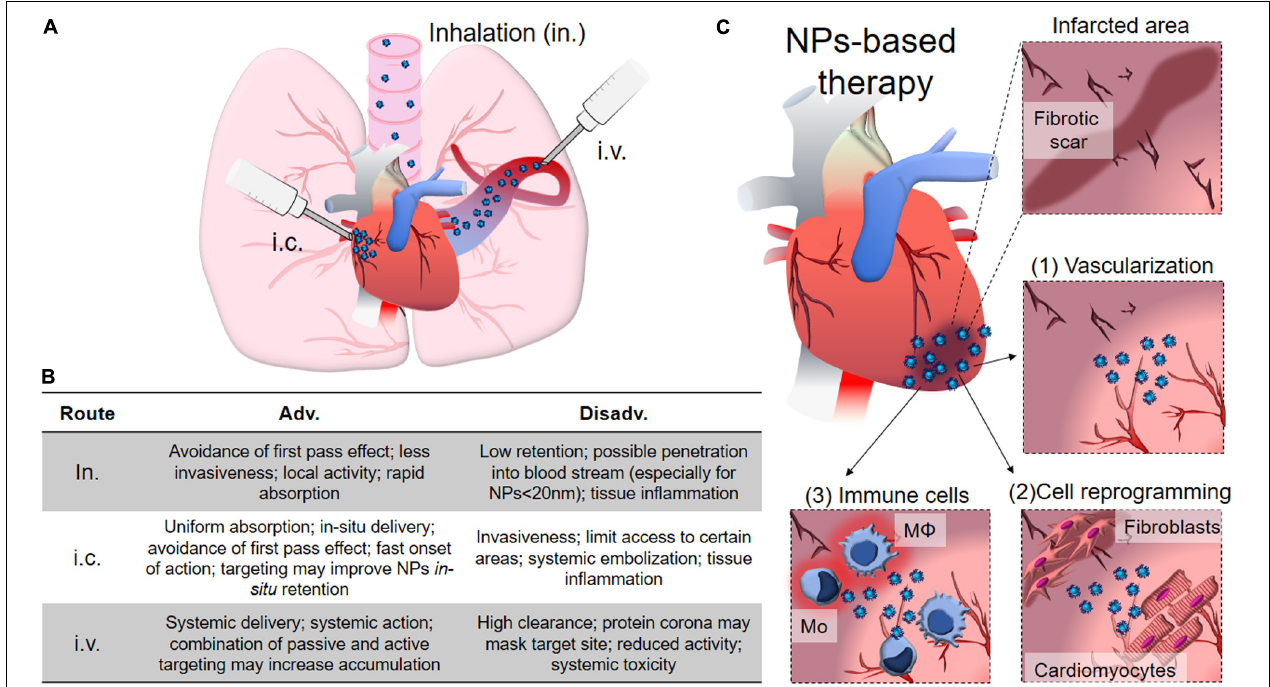
FIGURE 4 | NPs for cardiac diseases. (A) The administration routes currently evaluated for delivery therapy at heart include inhalation (in.), intra-cardiac injection (i.c.) and intra-venous injection (i.v.). (B) Table showing advantages and disadvantages of the different administration routes. (C) The infarcted area typically shows loss of vessels and various degrees of fibrotic scar formation with limited contractility and functionality that dramatically compromise heart functions. NPs can be conceived to help restoring vascularization by promoting angiogenesis (1), locally transdifferentiating fibroblasts into CMs, resolving the fibrotic scar (2), and promoting the anti-inflammatory polarization of immune system cells, like macrophages (M ϕ ) and monocytes (Mo). The main text provides detailed discussion for each of the points here briefly described.